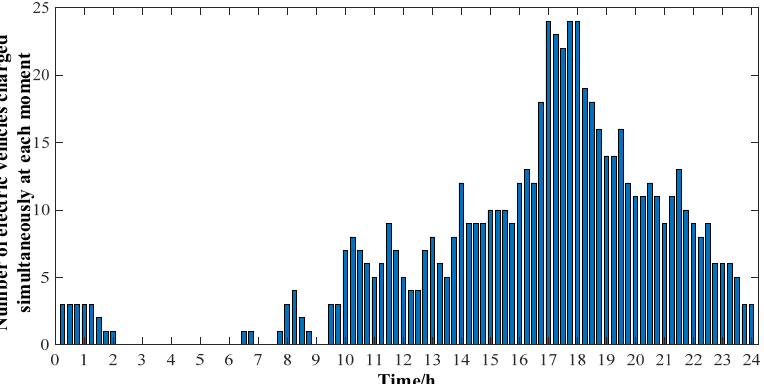
Figure 4. Number of EVs charged by moment on a typical day for 140 EVs.